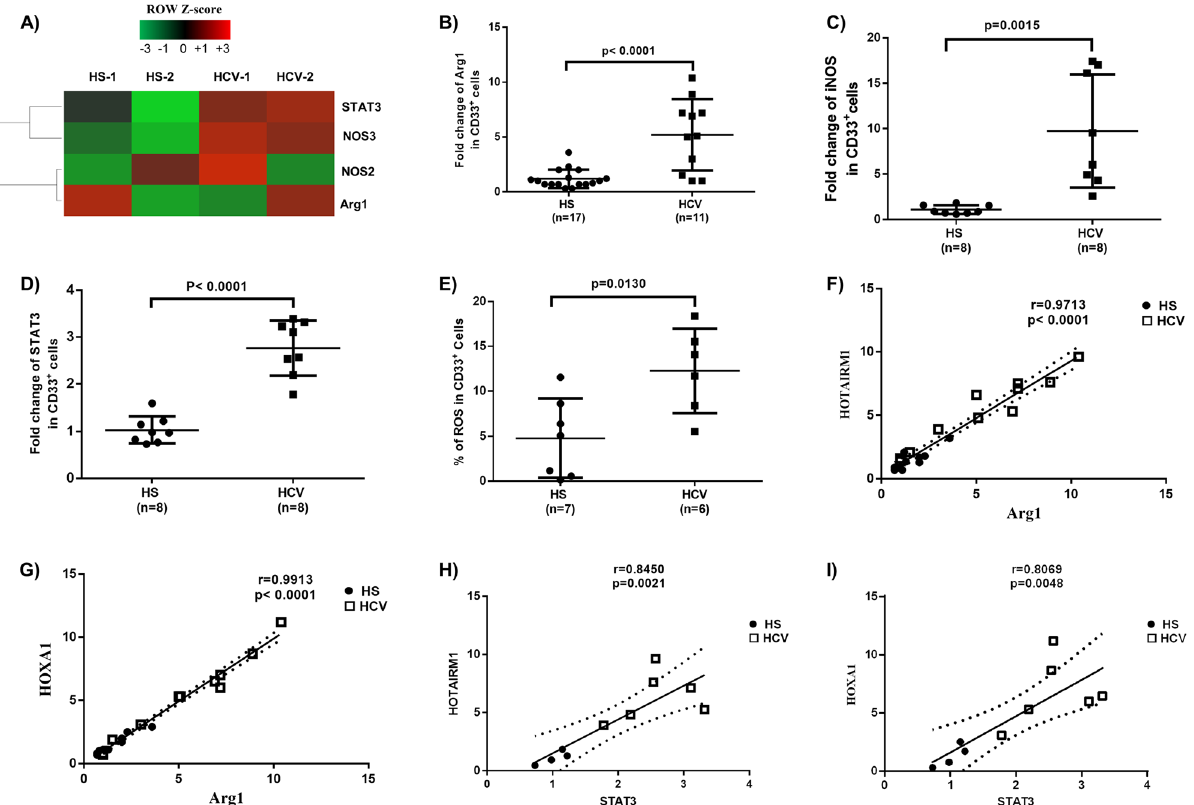
HS, analyzed by gene array. ( B–D ) Levels of Arg1, iNOS, and STAT3 gene expressions in CD33 + cells isolated from HCV-infected individuals versus HS, analyzed by RT-PCR. ( E ) ROS production in CD33 + cells derived from HCV-infected individuals versus HS, analyzed by the H2DCFDA assay. ( F – I ) Relationship between HOTAIRM1 or HOXA1 and Arg1 or STAT3 expression levels, analyzed by Pearson Correlation